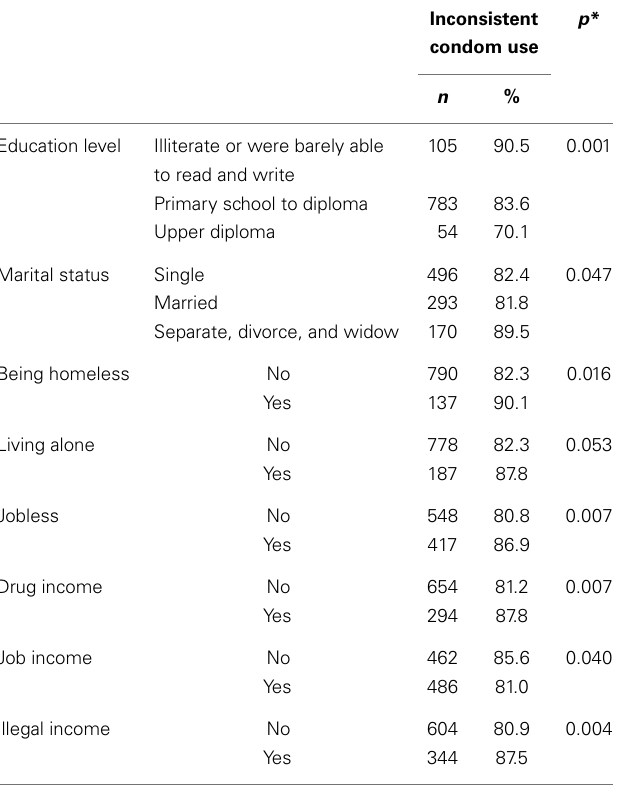
Table 2 | Bivariate associations between drug-related variables and inconsistent condom use